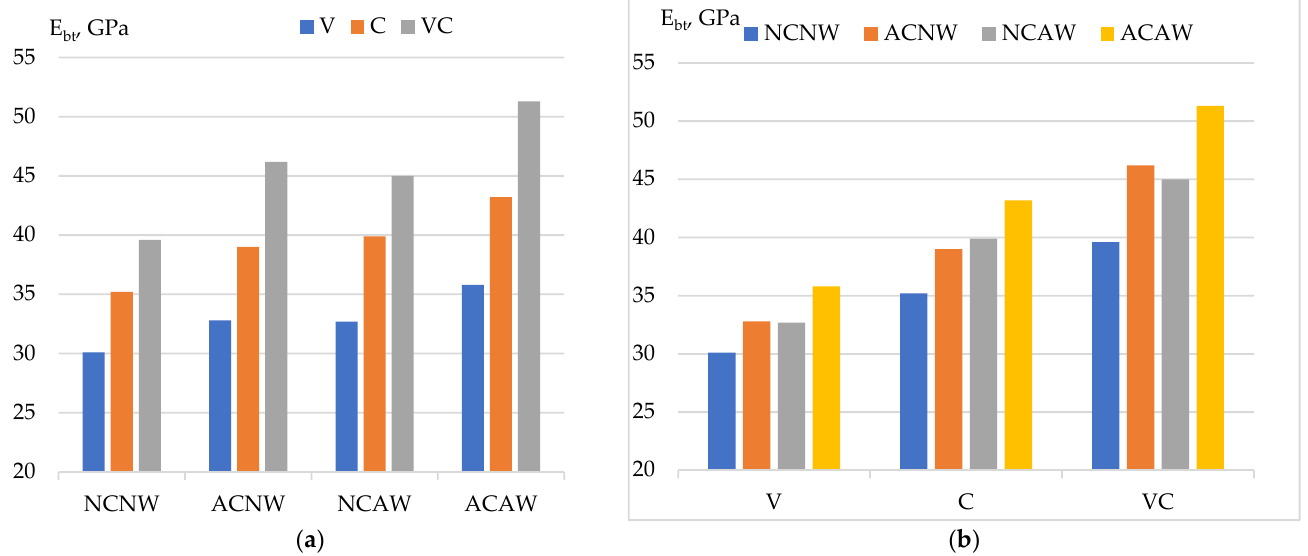
Figure 12. Dependence of the tensile modulus of concrete: ( a ) on the type of activation, ( b ) on the type of technology for its manufacture. Table 7. Results of experimental studies of the strength and deformation characteristics of concrete with various types of activation and manufacturing technology.